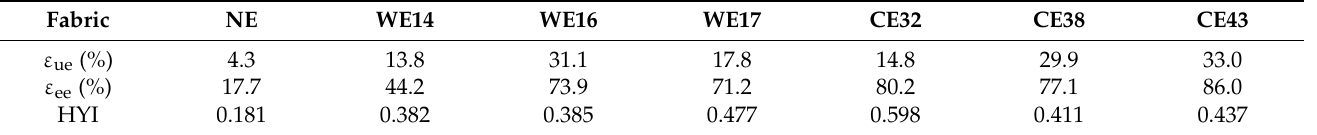
Figure 8. Diagrams of the results of cyclic loading and unloading of the knitted fabrics up to the elastic limit: ( a ) non-elastane knitted fabric; ( b ) knitted fabric with 14% wrapped elastane; ( c ) knitted fabric with 16% wrapped elastane; ( d ) knitted fabric with 17% wrapped elastane; ( e ) knitted fabric with 32% bare elastane; ( f ) knitted fabric with 38% bare elastane; ( g ) knitted fabric with 43% bare elastane. The values of unrecovered elongation ( ε ue ), elastic elongation ( ε ee ), and hysteresis index (HYI) in the fifth loading–unloading cycle of the knitted fabrics in the wale direction are listed in Table 6, and for the course direction in Table 7. Equations (1)–(3) were used to calculate the values. Table 6. Unrecovered elongation ( ε ue ), elastic elongation ( ε ee ), hysteresis index (HYI) in the 5th cycle in the wale direction.